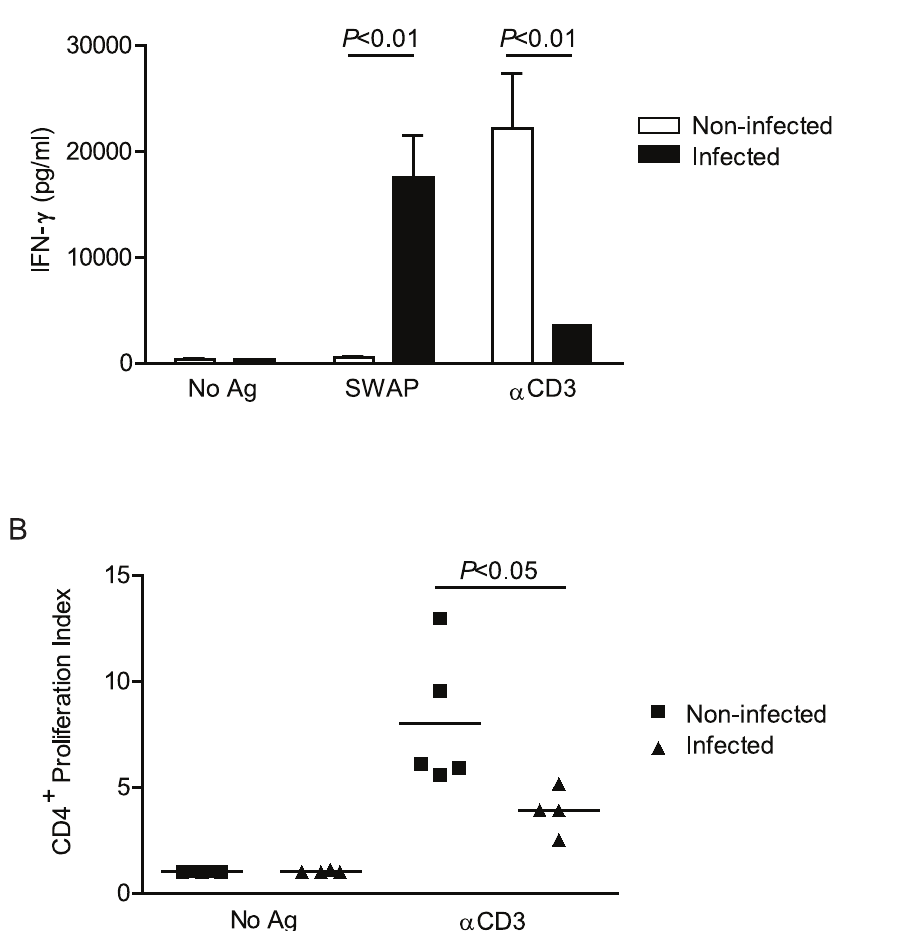
Figure 1. Pre-patent schistosome infection impairs T cell production of IFN- c and proliferation of CD4 + T cells in response to polyclonal stimulation. A, Splenocytes isolated from 4 week S. mansoni -infected or non-infected wild type mice were cultured in vitro for 72 hours without antigen, with SWAP or with anti-CD3 antibody. The concentration of IFN- c was measured from cell culture supernatant by ELISA. Data shown are mean + / 2 SEM. B, Splenocytes isolated from 4 week-infected or non-infected wild type mice were stained with CFSE and cultured for 72 hrs without antigen or with a CD3 antibody. Cells were recovered from culture, stained for surface markers, then CFSE dilution due to cell division was analyzed by flow cytometry and proliferation index calculated. Horizontal bars represent mean value of 5 independent mice. Data are representative of 3 independent experiments. No Ag, no antigen; SWAP, soluble worm antigen preparation; a CD3, anti-CD3 antibody.